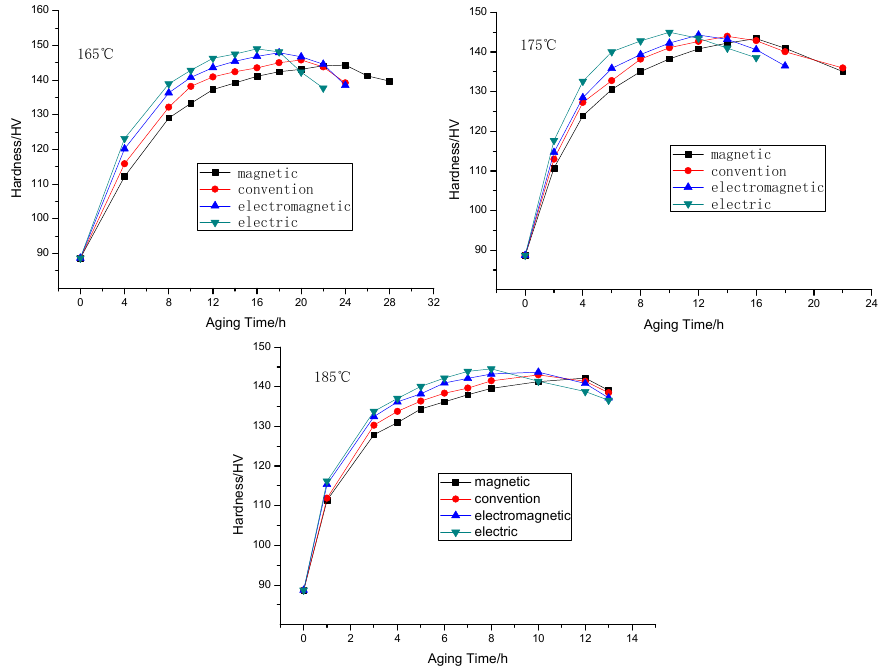
Figure 2. Ageing hardening curves under different external fields.